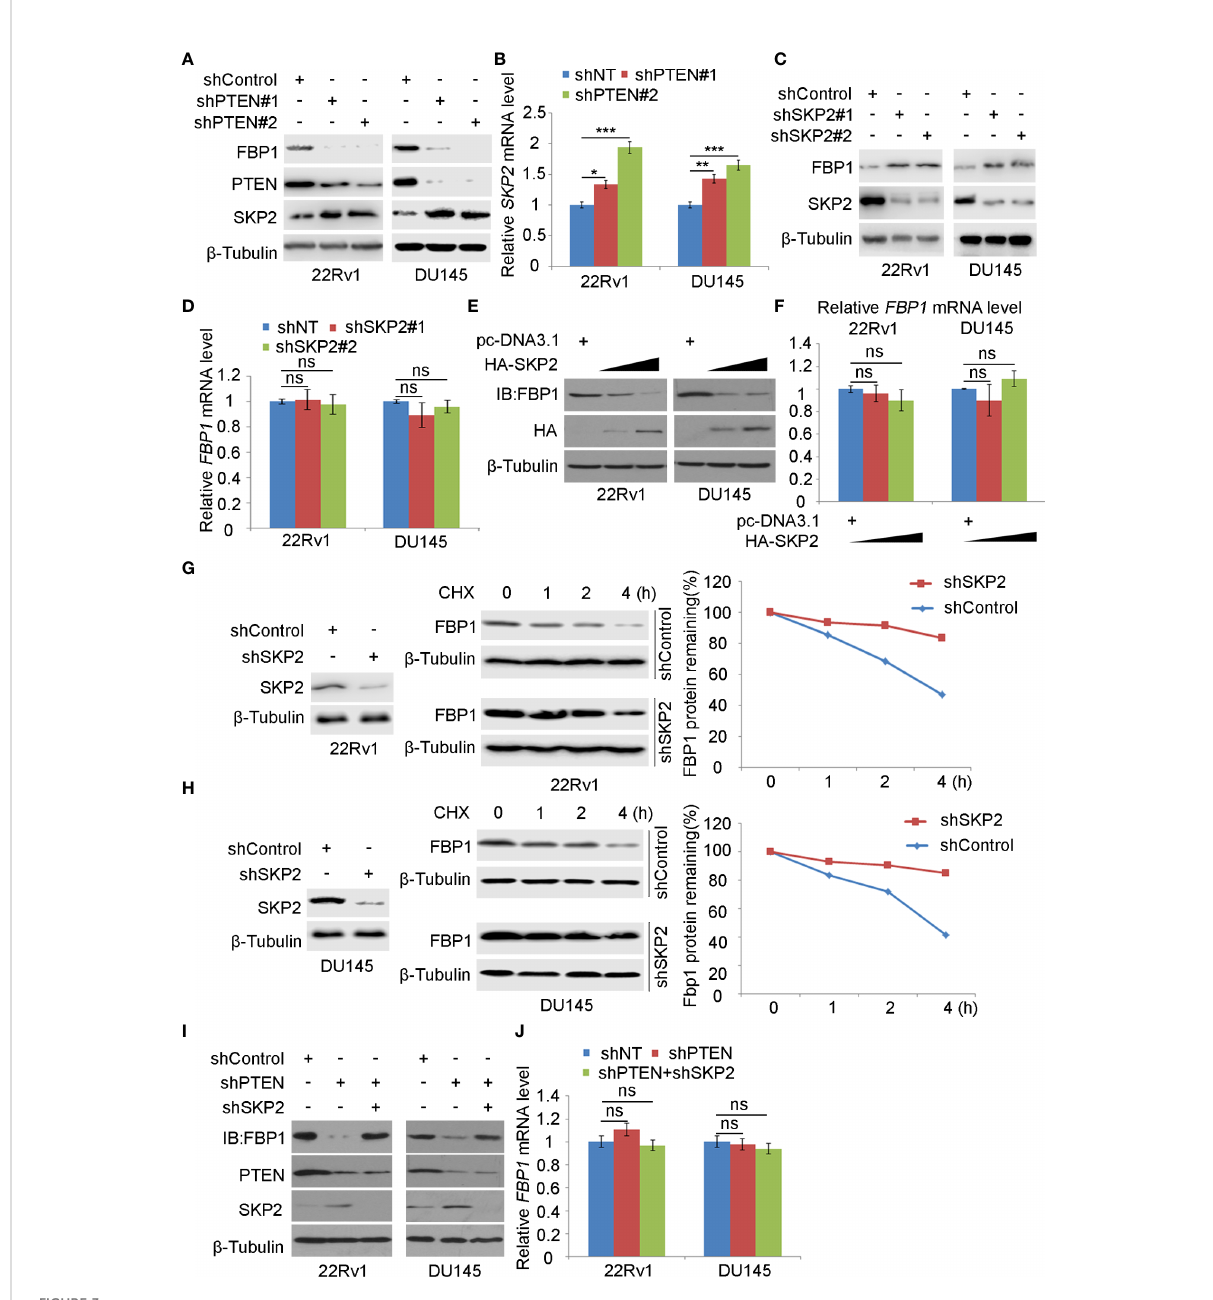
FIGURE 3 SKP2 mediates FBP1 protein ubiquitination and degradation induced by PTEN loss (A, B) WB (A) and quantitative RT-PCR (B) analyses were carried out in 22Rv1 and DU145 cells infected with lentivirus expressing control or PTEN-speci fi c shRNAs for 48 hours. b -Tubulin was used as a WB loading control. All quantitative data are shown as Mean ± SD (n=3). Student ’ s t test. *P < 0.05, **P<0.01, ***P<0.001. (C, D) WB (C) and quantitative RT-PCR (D) analyses were performed in 22Rv1 and DU145 cells infected with lentivirus expressing control or SKP2-speci fi c shRNAs for 48 hours. b -Tubulin was used as a WB loading control. All quantitative data are shown as Mean ± SD (n=3). Student ’ s t test. n.s., not signi fi cant. (E, F) WB (E) and quantitative RT-PCR (F) were conducted using samples obtained from 22Rv1 and DU145 cells transfected with pcDNA3.1 or HA-SKP2 expression plasmid for 24 hours. All quantitative data are shown as Mean ± SD (n=3). Student ’ s t test. n.s., not signi fi cant. (G, H) WB and quanti fi cation of WB bands were carried out in 22Rv1 (G) and DU145 cells (H) infected with shControl or SKP2-speci fi c shRNAs for 48 hours and treated with 50 m g/ml cycloheximide (CHX) for different periods of time. At each time point, the intensity of FBP1 WB band was normalized to the intensity of b -Tubulin (a WB loading control) fi rst and then to the value at the 0-h time point. (I, J) Western blot (I) and quantitative RT-PCR (J) analyses were conducted in 22Rv1 and DU145 cells infected with lentivirus expressing the indicated shRNAs for 48 hours. All quantitative data are shown as Mean ± SD (n=3). Student ’ s t test. n.s., not signi fi